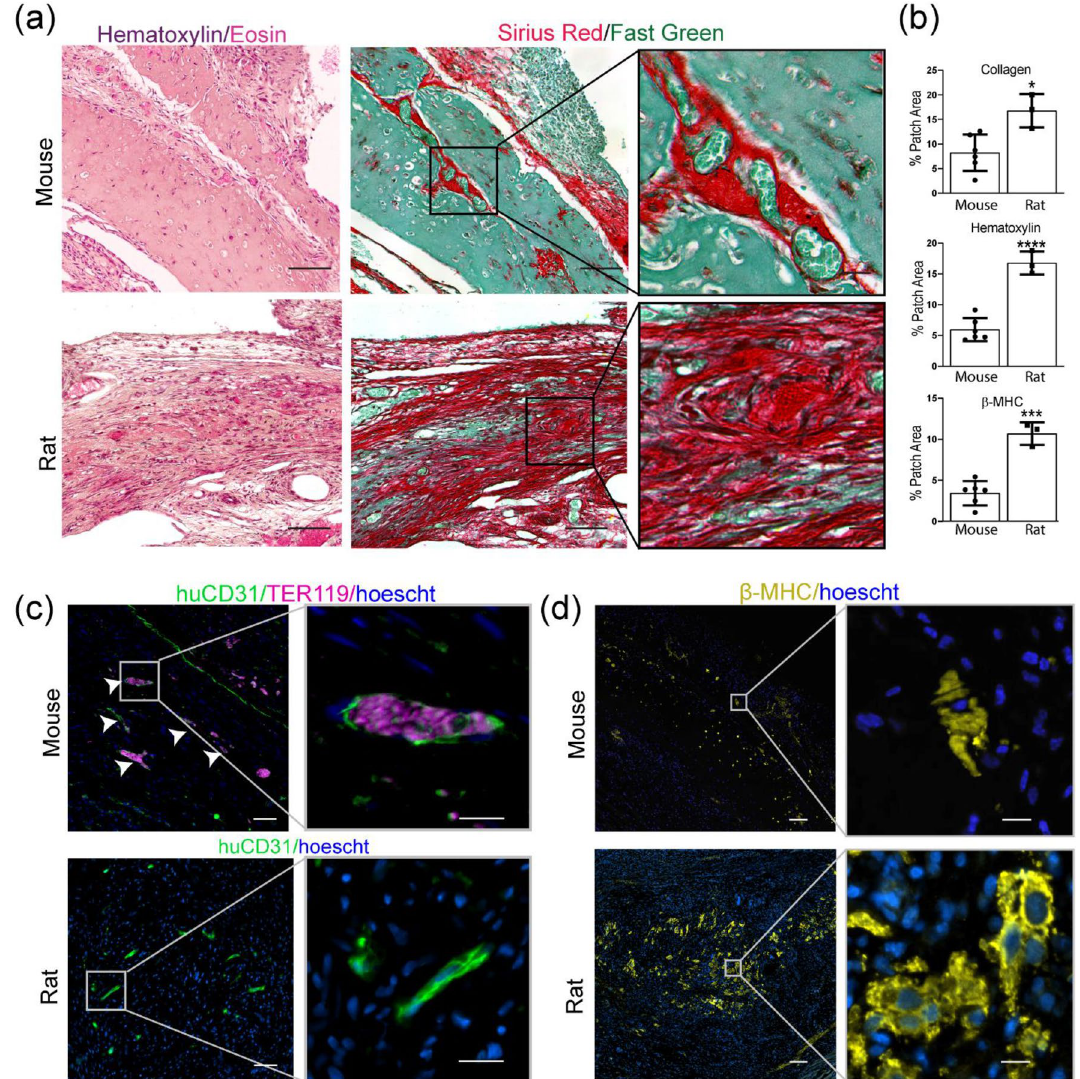
Figure 4. Cords-containing cardiac patch induces patterned vasculature in mice, but robust inflammation in rat at 10 days post-implantation. ( a ) H&E and Sirius Red/Fast Green show hematoxylin-positive nuclear infiltrate and SR+ collagen in patches implanted in rats, but minimal inflammation in mice. Patches in mice have blood pools associated with cords (inset). Scale bar = 100 μm. Inset scale bar = 20 μm. ( b ) Quantification of collagen, nuclei, and human myocardium as percent of patch area in rats and mice. Error bars report S.D. n = 6 (mice) n = 3 (rats). ( c ) In mice, huCD31 staining reveals cords-associated clusters of graft-derived vessels filled with TER-119 + blood (white arrows indicate cords). huCD31 staining in rats fails to recapitulate cords patterning. Scale bar = 50 μm. Inset scale bar = 20 μm ( d ) Human cardiac graft size is larger in rats than mice. Scale bar = 100 μm. Inset scale bar = 10